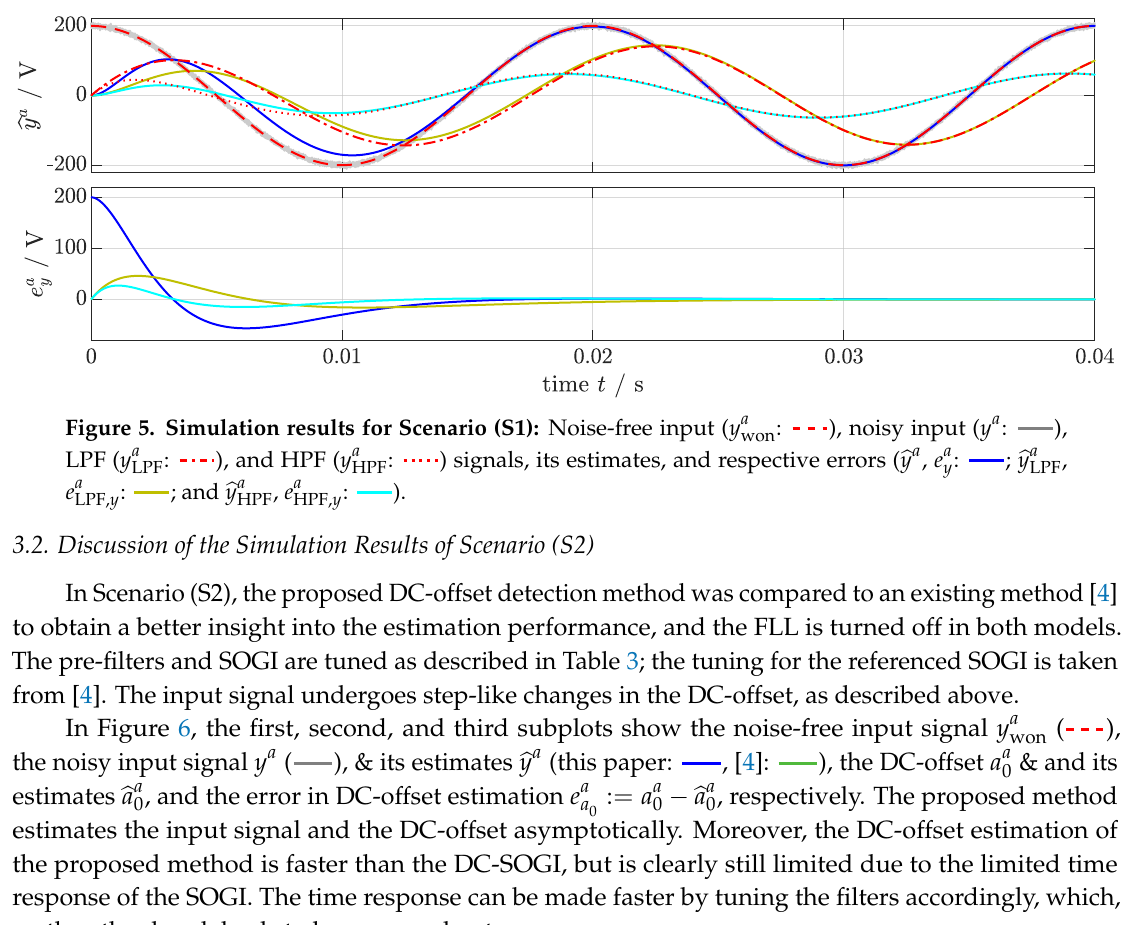
Figure 5. Simulation results for Scenario (S1): Noise-free input ( y a